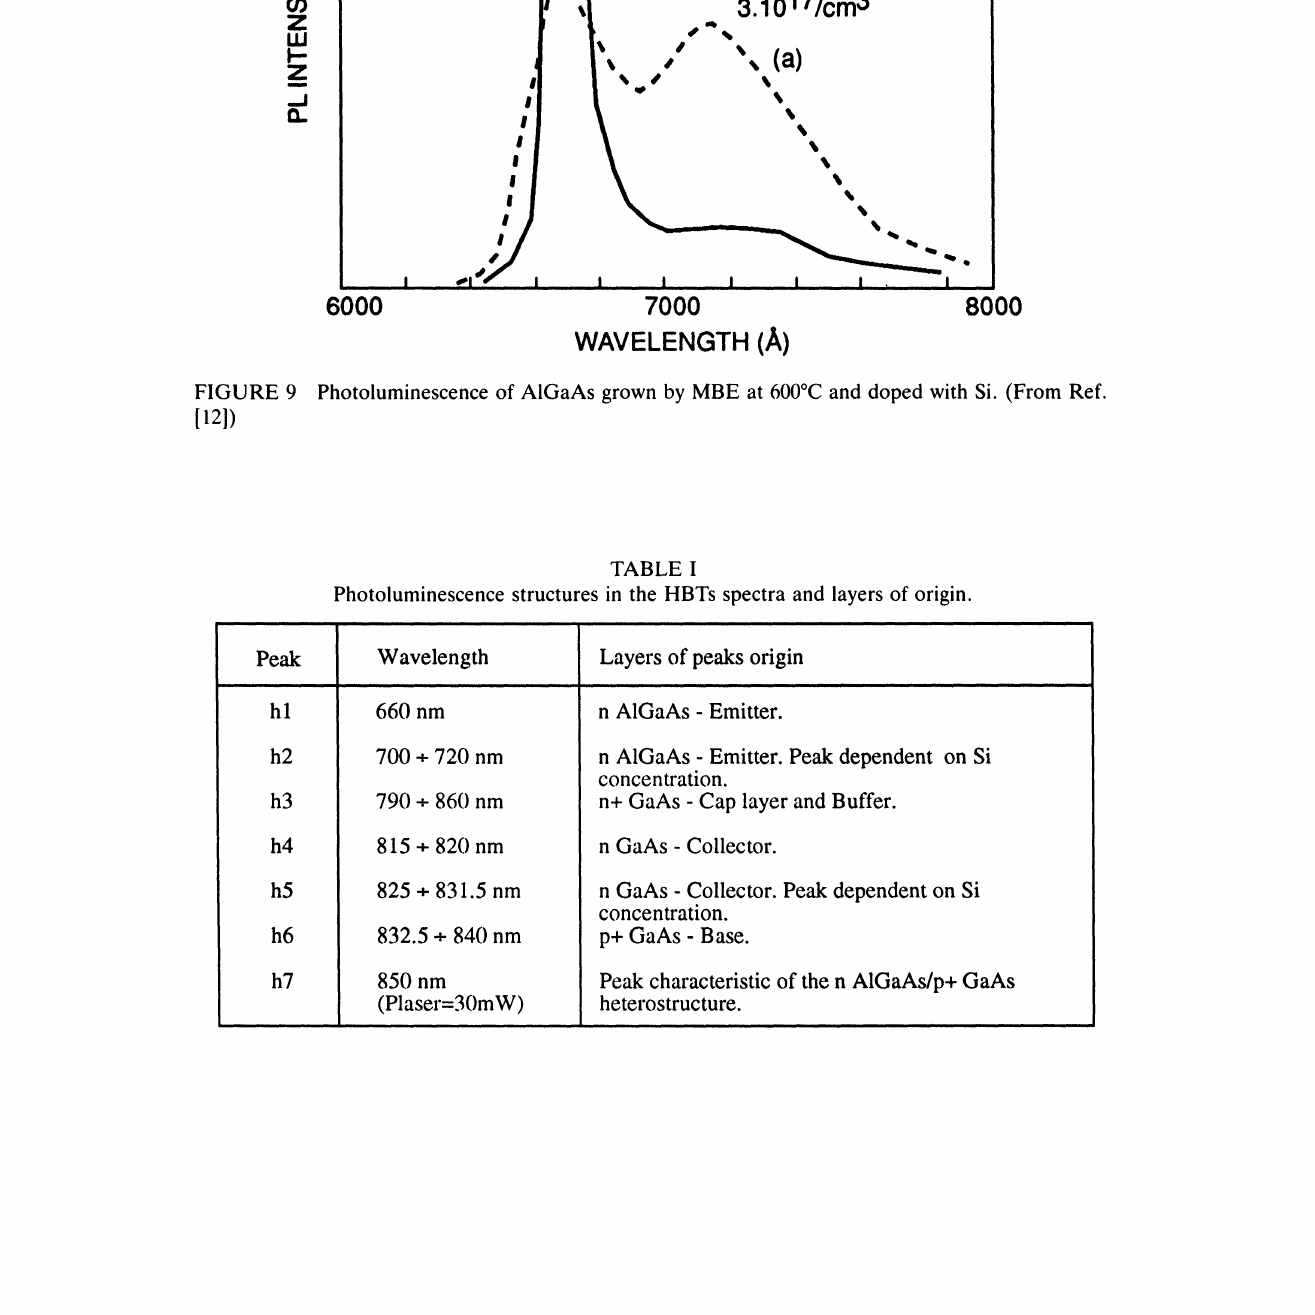
FIGURE 9 Photoluminescence of AIGaAs grown by MBE at 600C and doped with Si. (From Ref. 121)